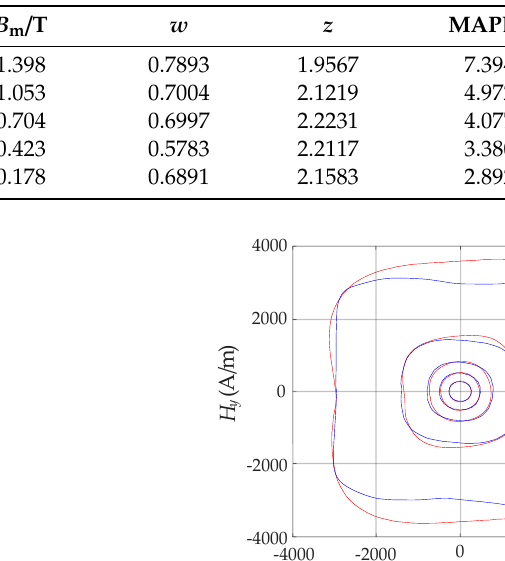
Table 2. Values of parameters and error extracted by hybrid algorithm of PSO – Powell.